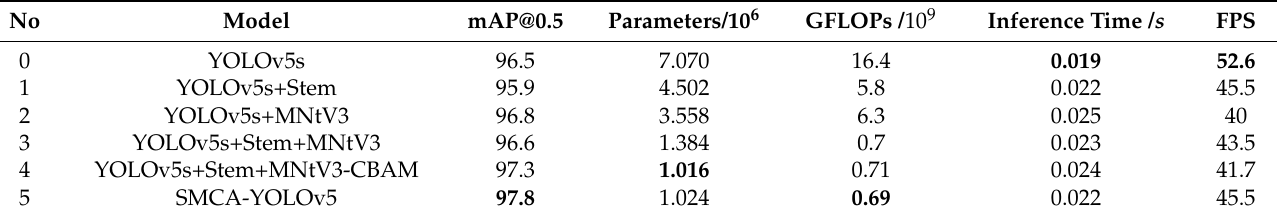
Table 2. Results of ablation